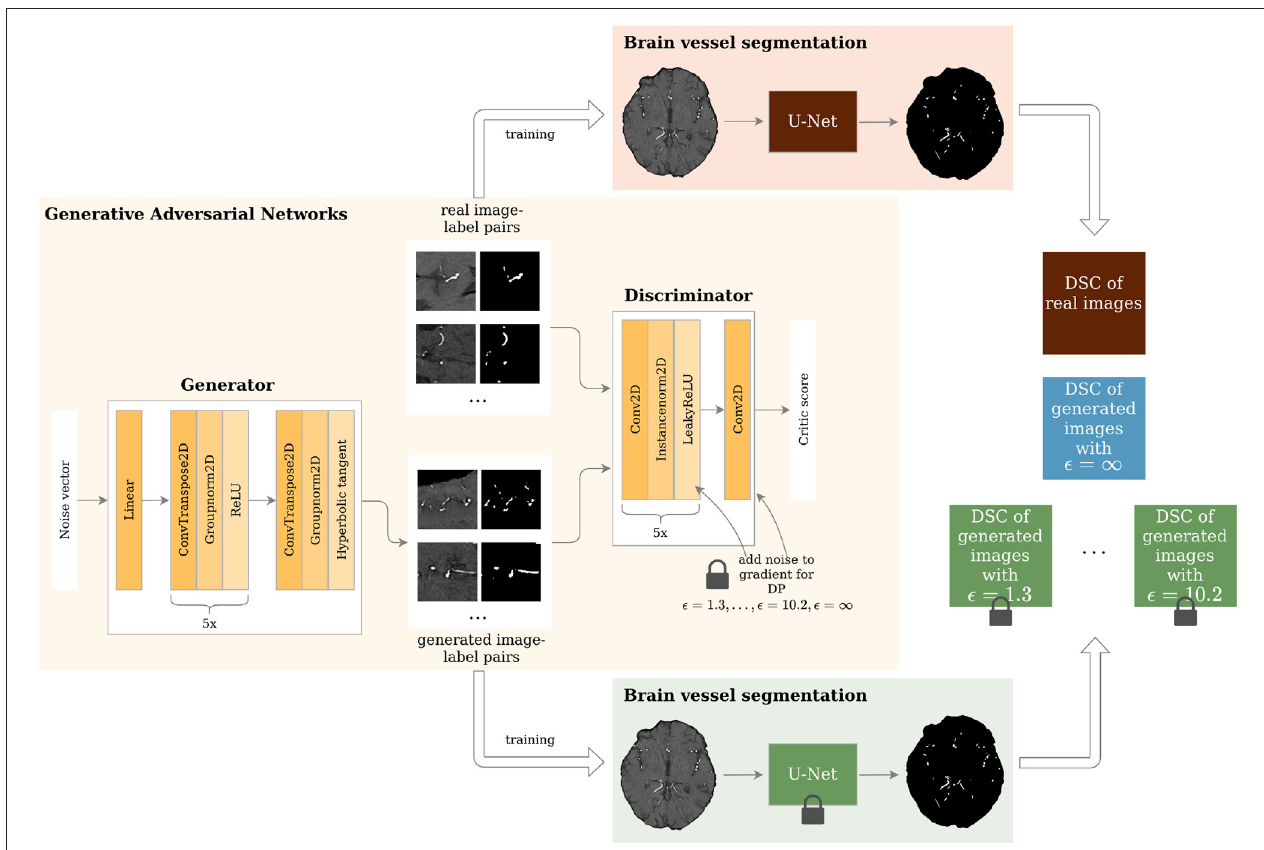
FIGURE 1 | Study overview. Generative Adversarial Networks (GANs) with different levels of privacy guarantees are trained to synthesize labeled Time-of-Flight Magnetic Resonance Angiography (TOF-MRA) patches. These are evaluated in a brain vessel segmentation paradigm and are compared to a segmentation network trained on real patient image-label pairs. DP = Differential Privacy; DSC = Dice Similarity Coefficient.